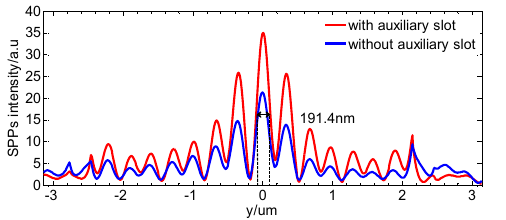
Figure 7. The intensity profile of the hot spot along the y-axis in the center of the surface plasmonic lens with and without the auxiliary spiral slot illuminated by a y-axis direction polarized light, w 1 = 310 nm, w 2 = 155 nm, h 1 = 110 nm, h 2 = 45 nm, r 0 = 2000 nm, m = 1, λ = 633 nm.